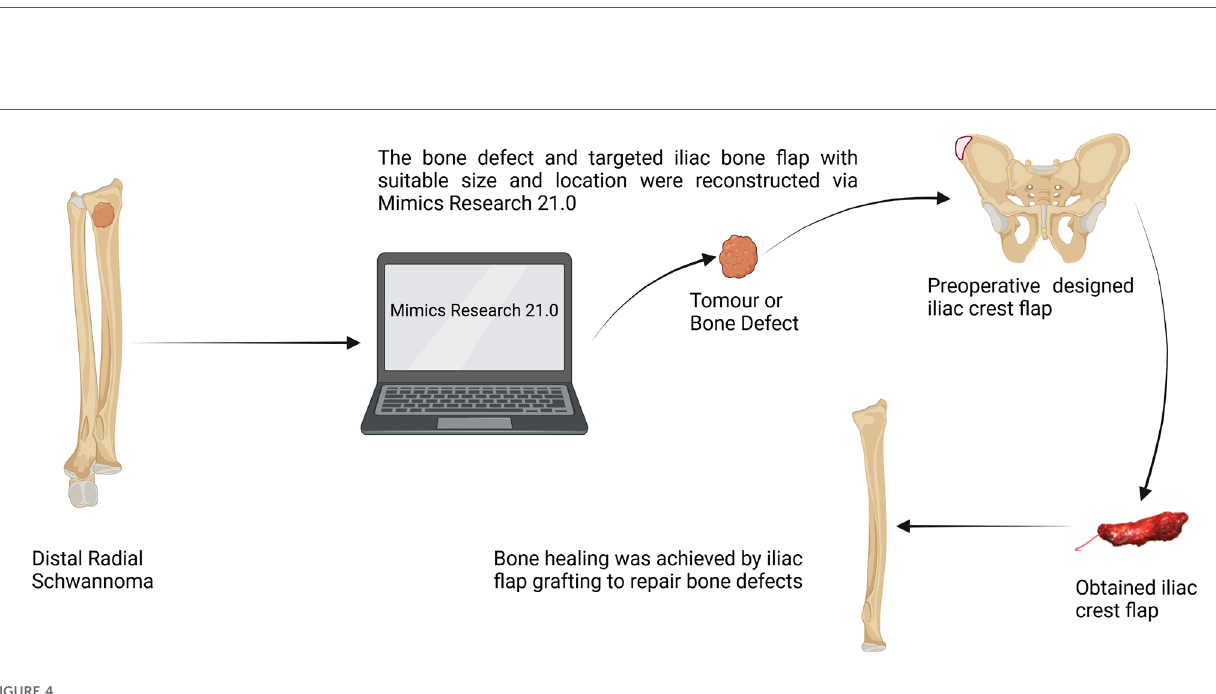
FIGURE 3 ( A ) 3D-CT reconstruction of the radius (yellow) and tumor (blue, white arrow) in the translucent view. ( B ) Radius (yellow) after tumor removal. The white arrow indicates the location of the bone defect. ( C ) Radial tumor (blue) after 3D reconstruction. ( D ) 3D reconstruction imaging (green: iliac crest, white arrow: blood supply). ( E,F ) Radiography revealing satisfactory healing (white triangle) of the radial bone defect 12 months postoperatively. 3D, three-dimensional.